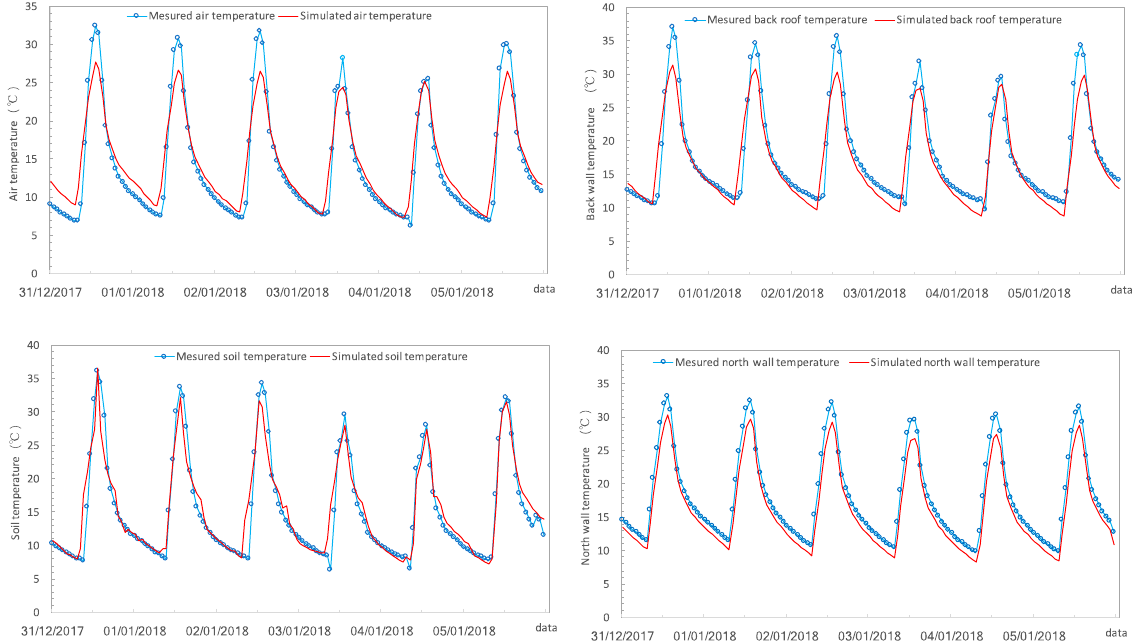
Figure 12. Relationship between simulated and measured temperature variations during cloudy days.